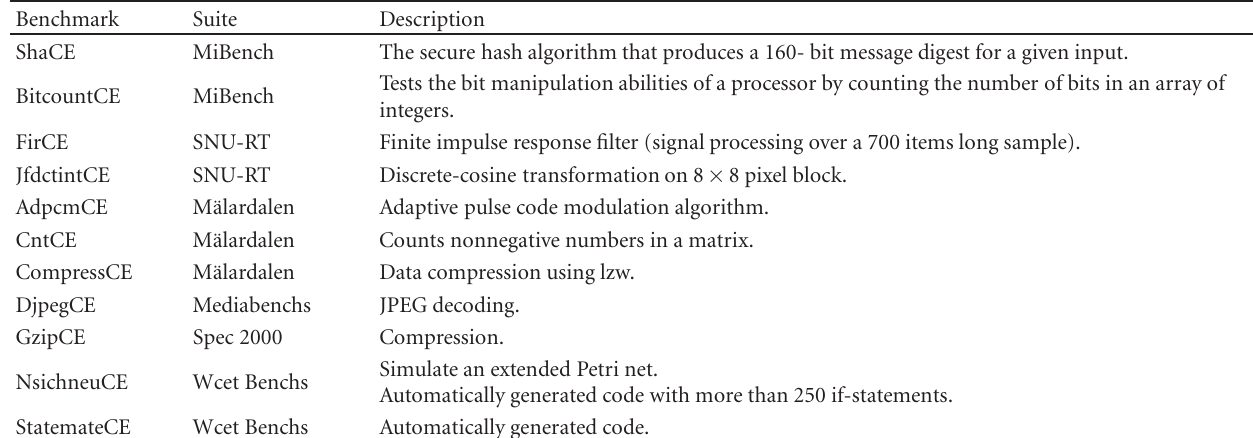
Table 7: List of